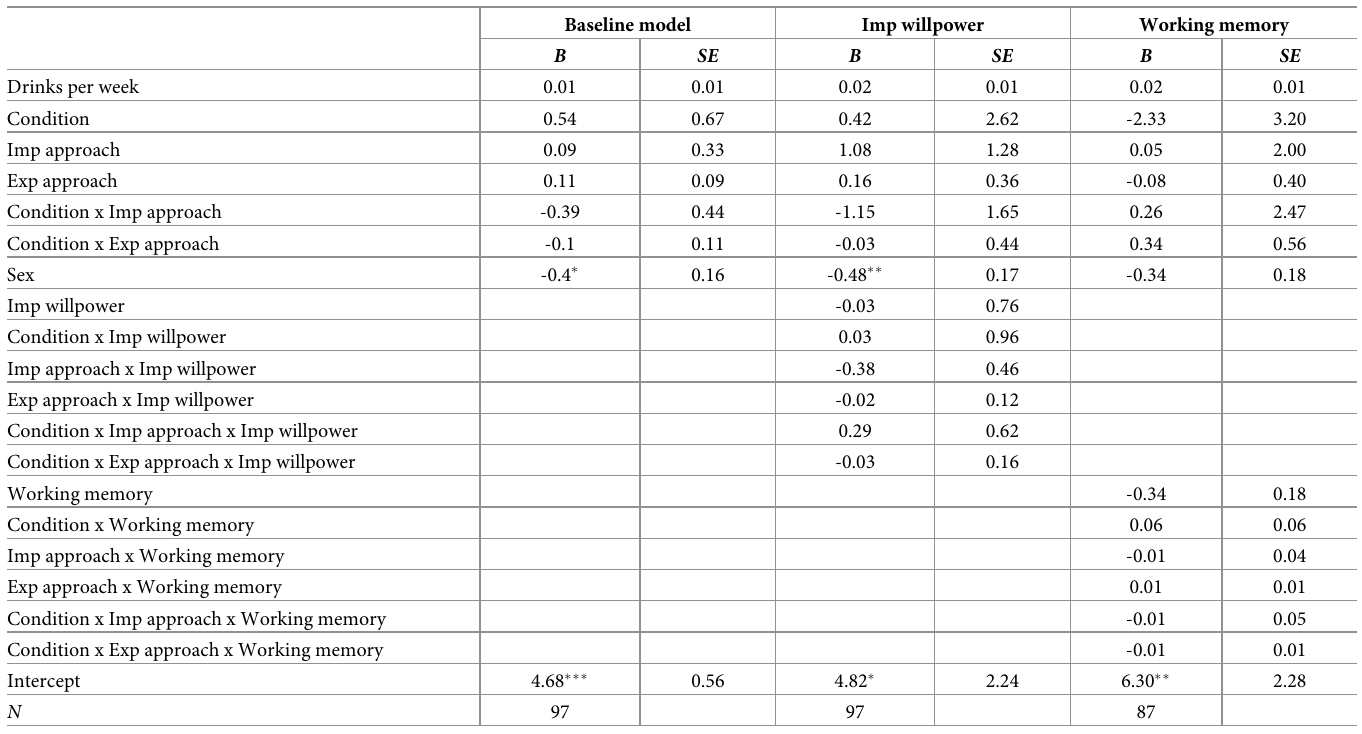
Table 6. Alcohol approach